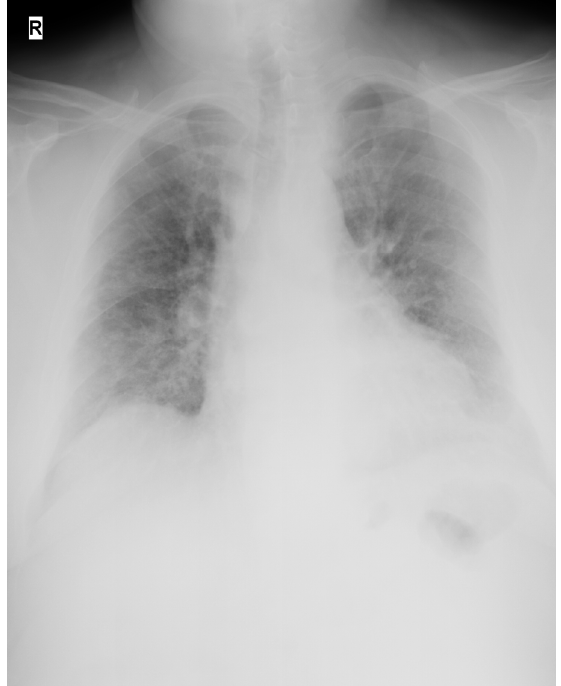
Figure 1. Posteroanterior chest X-ray at presentation in the ER. Multiple areas showing ground-glass opacities, on both pulmonary areas, amounting to 50% pulmonary damage. Day of admission.